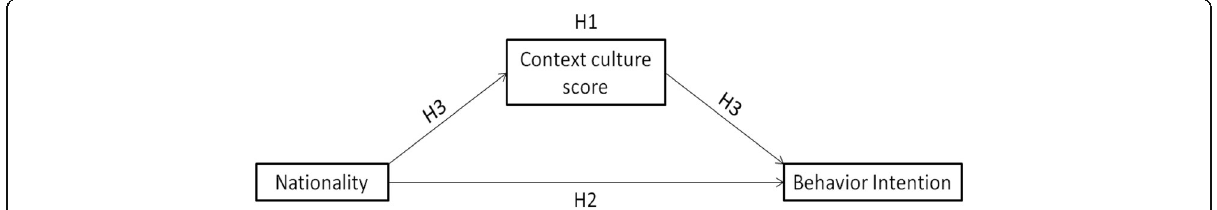
Fig. 1 Theoretical model of the role of context culture in humanitarian behavior intention (source: Elaboration of the